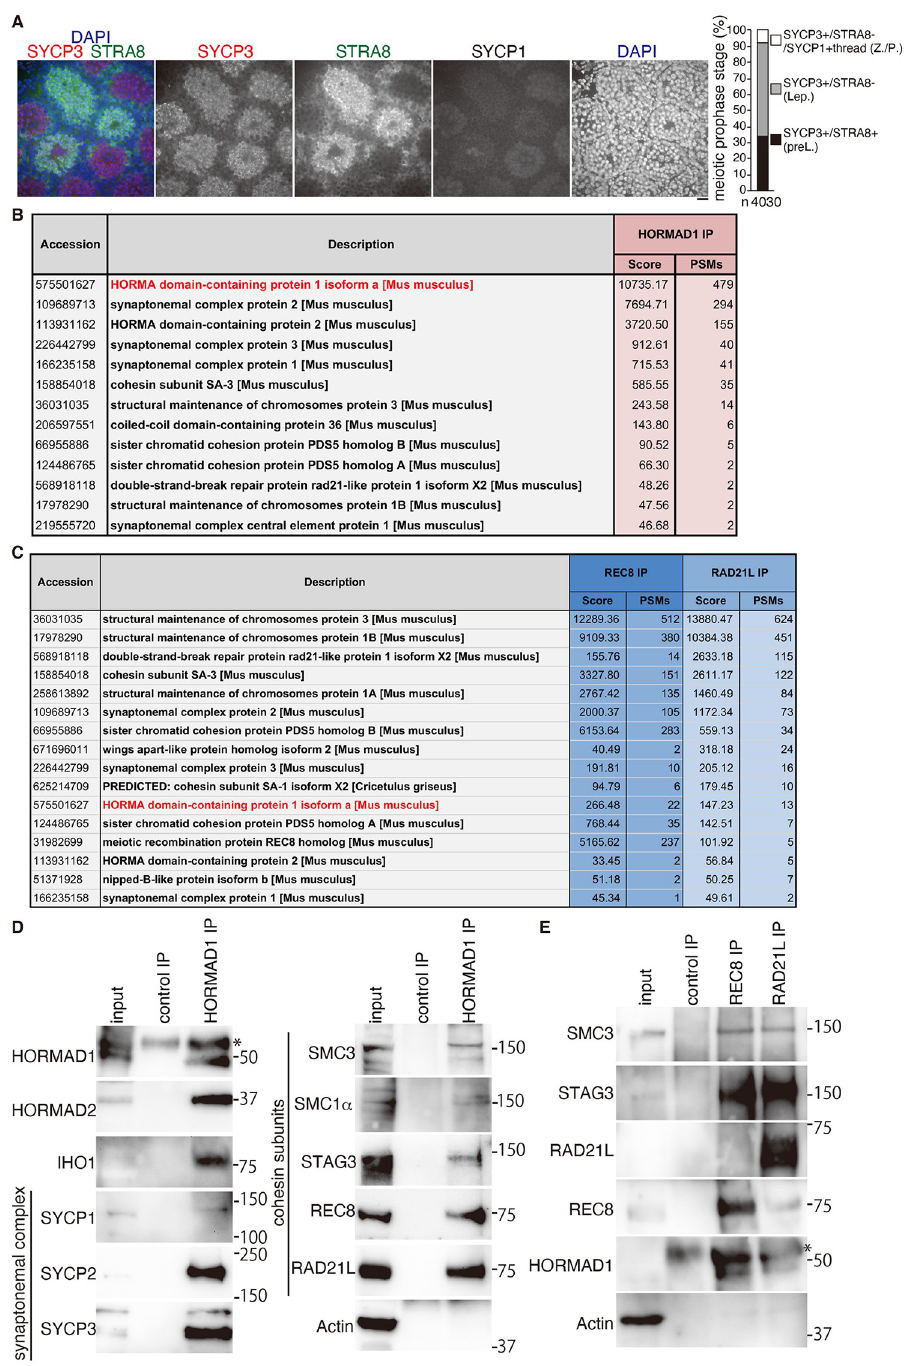
Fig 1. HORMAD1 interacts with cohesin and chromosome axis proteins. (A) WT neonatal male mice were subjected to consecutive injection of a RA synthesis inhibitor WIN18,446, followed by injection of RA. Seminiferous tubule section at 8 days post treatment were stained for SYCP3, STRA8, SYCP1(Cy5) and DAPI. Scale bar: 25 μ m. Proportion of the meiotic prophase stages of spermatocytes is shown on the right. n: number of SYCP3 positive cells examined. preL: SYCP3+/STRA8+ preleptotene, Lep: SYCP3+/STRA8- leptotene. As weak staining of SYCP1 over spermatocyte nuclei was detected even in preleptotene and leptotene, spermatocytes with thread-like pattern of SYCP1 staining was defined as Z./P.: zygotene or pachytene. (B) The immunoprecipitates by anti-HORMAD1 antibody from the chromatin-bound fraction of the testis were subjected to liquid chromatography tandem-mass spectrometry (LC-MS/MS) analyses. The proteins identified by the LC-MS/MS analyses are listed with the number of peptide hits